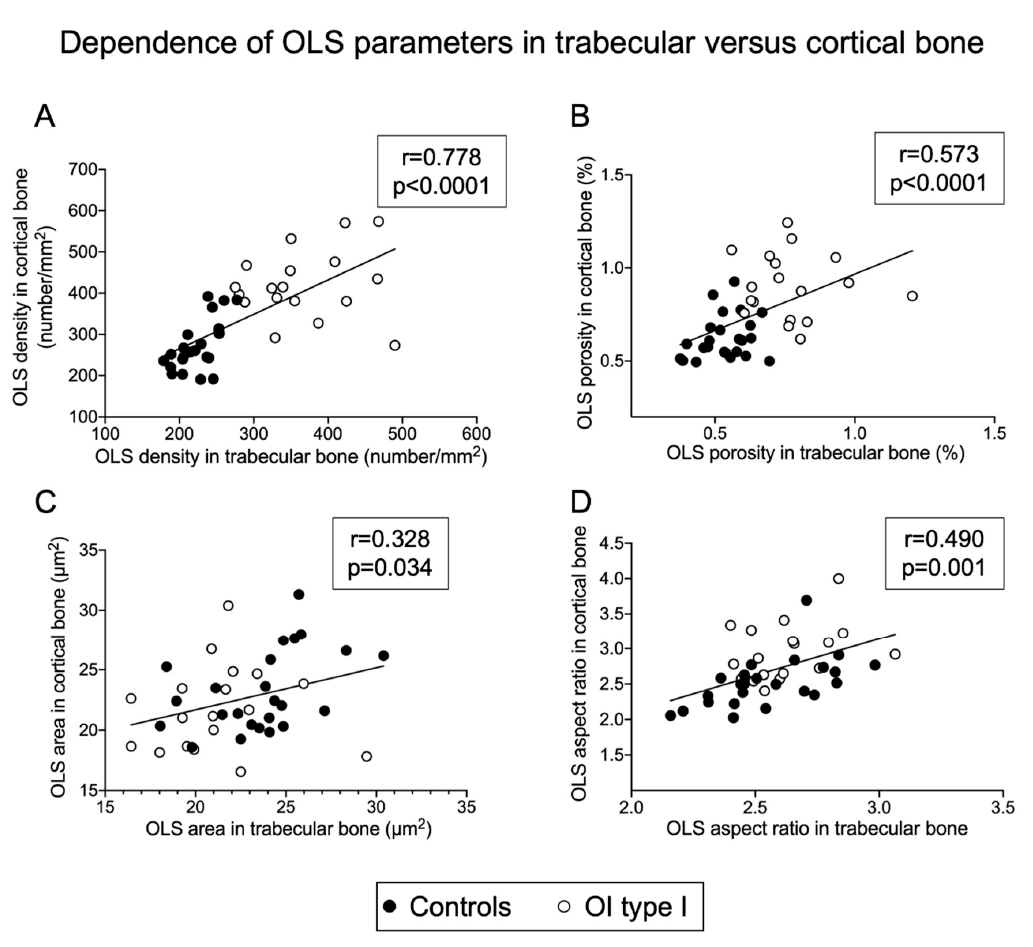
Figure 3. Dependency of OLS density ( A ), OLS porosity ( B ), OLS area ( C ) and OLS aspect ratio ( D ) in trabecular versus cortical bone (total sample analysis). Note that OLS density and OLS porosity in OI type I bone (white circles) is always higher than in controls (black circles). In contrast, there is no clear separation between both groups for OLS area and OLS aspect ratio.